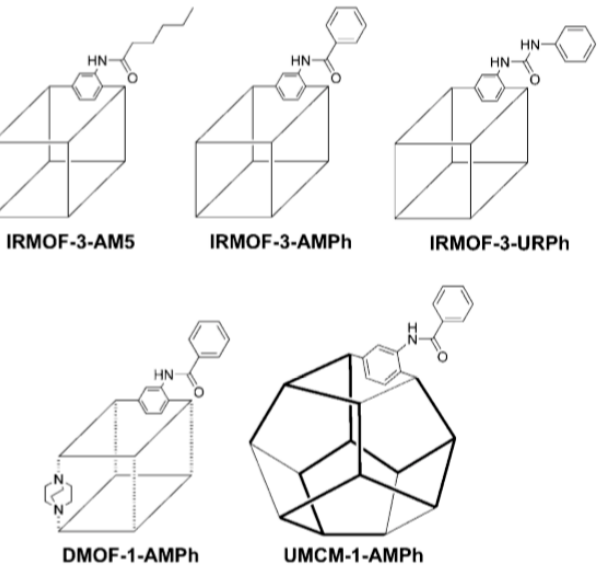
Figure 12. Schematic representation of pore functionalization by amide groups in IRMOF-3-AM5, IRMOF-3-AMPh, IRMOF-3-URPh, DMOF-1-AMPh, and UMCM-1-AMPh. Reprinted with permission from [188]. Copyright © 2010, Wiley-VCH Verlag GmbH&Co. KGaA, Weinheim. All rights reserved.